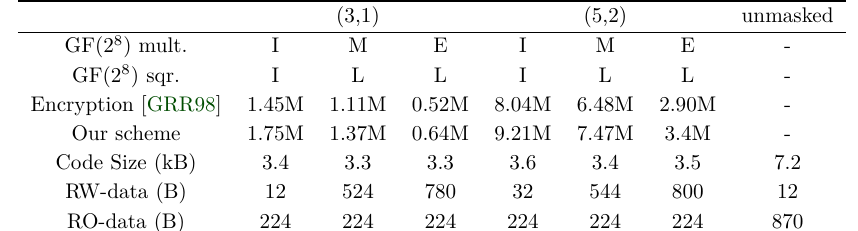
Table 7: AES-128 encryption execution time, code and RW-data size depending on the GF(2 8 ) operations variations. I:Instruction Only, M:Mixed, L:LUT, E:Exp-Log.